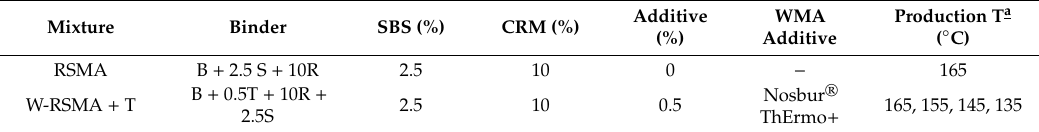
Table 4. Control mixture and stone mastic asphalt with warm mix asphalt additives.